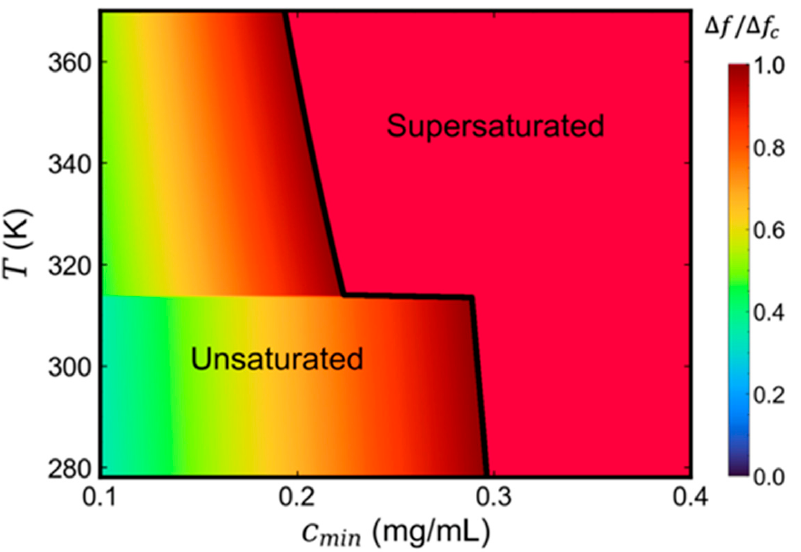
Figure 4. Phase diagram of the DPPC SLB coverage produced using the SALB method as a function of temperature and lipid concentration.